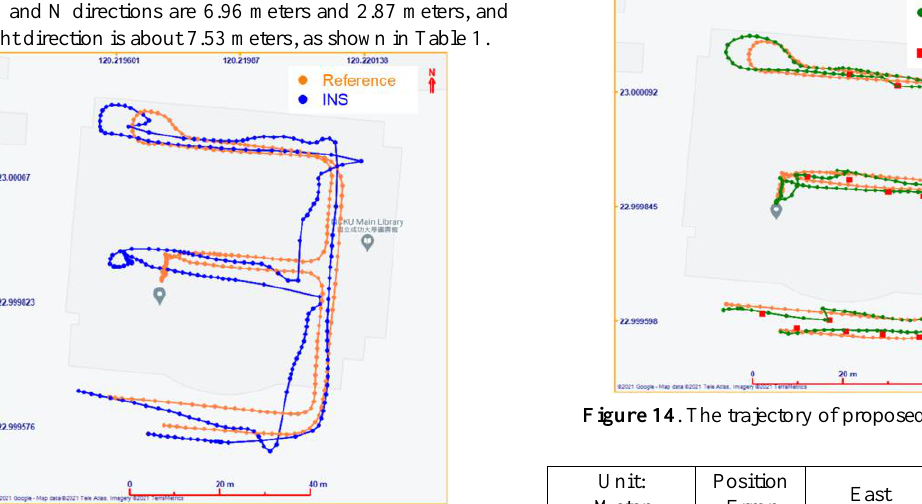
Figure 12. The trajectory of INS integration method